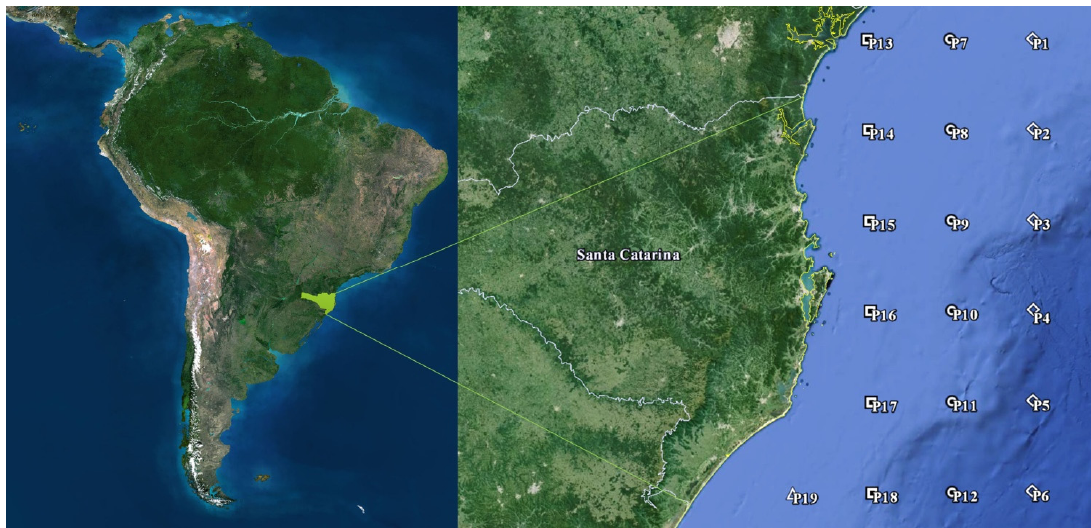
Figure 1. Map of Santa Catarina coast showing the location of European Centre for Medium-Range Weather Forecasts (ECMWF) grid study points.